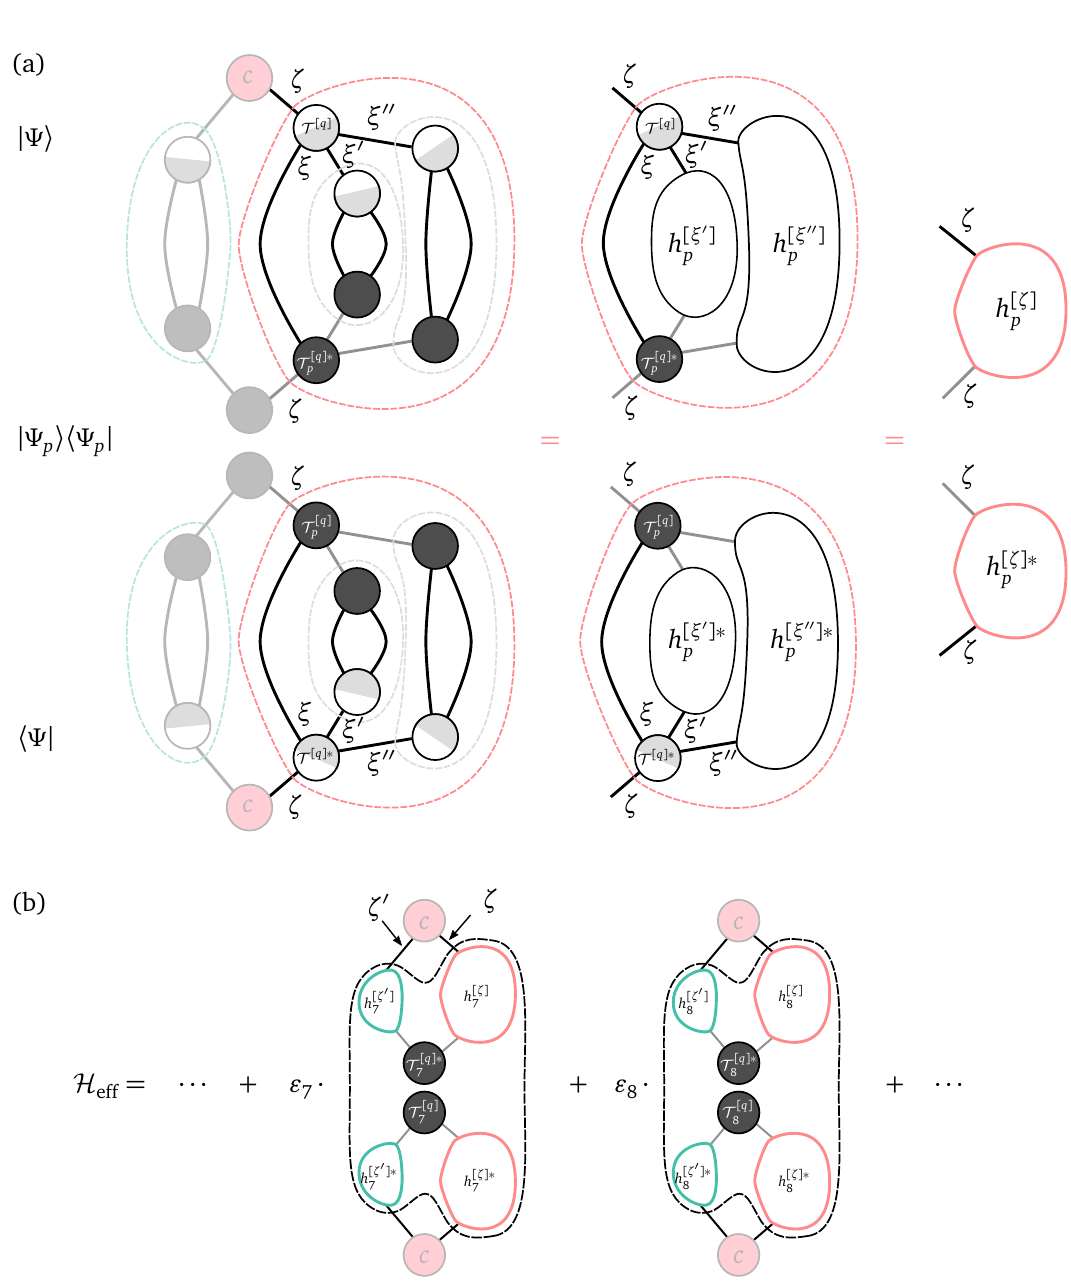
Figure 41: Example for the renormalization process that leads to the renormalized projection operators: (a) Renormalized projector terms h below the center node c by iteratively contracting state tensors with the renormalized projector terms of the previous level (dashed circles). (b) For a given center c , we can then determine the projector contributions to the effective Hamiltonian H summing over the renormalized projector terms acting on the links of c